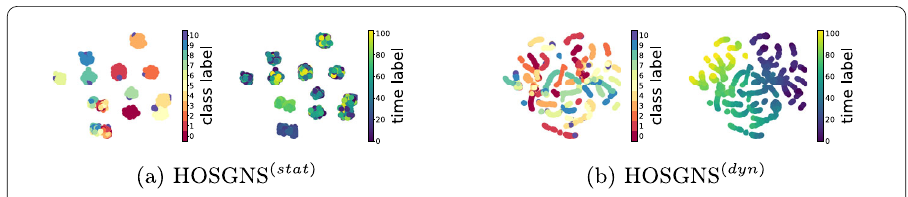
between ( i , k ) ∈ V ( T )